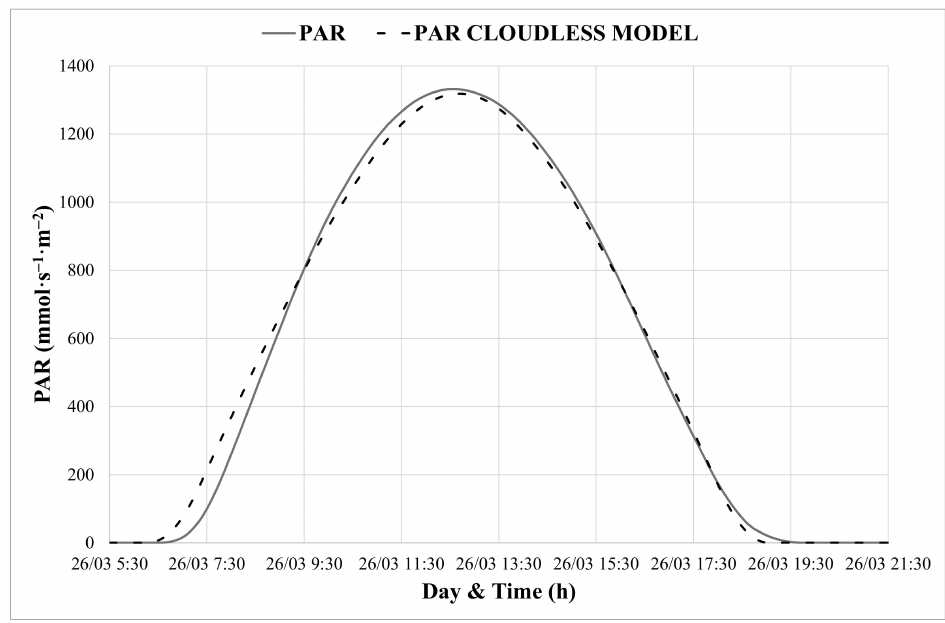
Figure 5. PAR model performance for a sunny